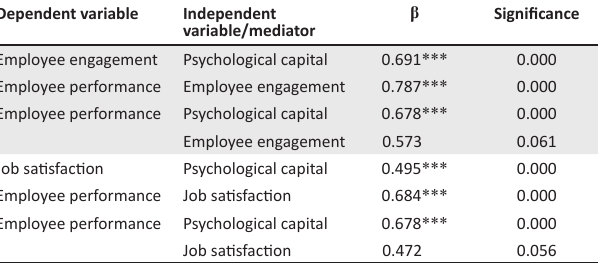
FIGURE 9: Job satisfaction mediation analysis results. TABLE 5: Correlations of dependent and independent variables and mediators.